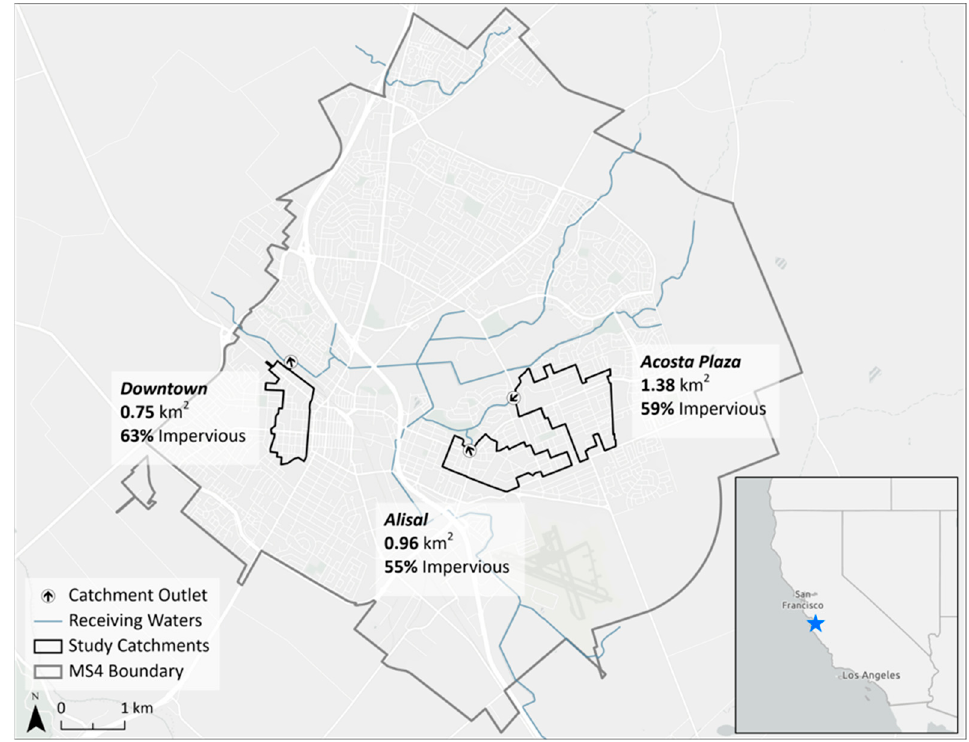
Figure 2. Study catchment locations and attributes within the City of Salinas, CA,